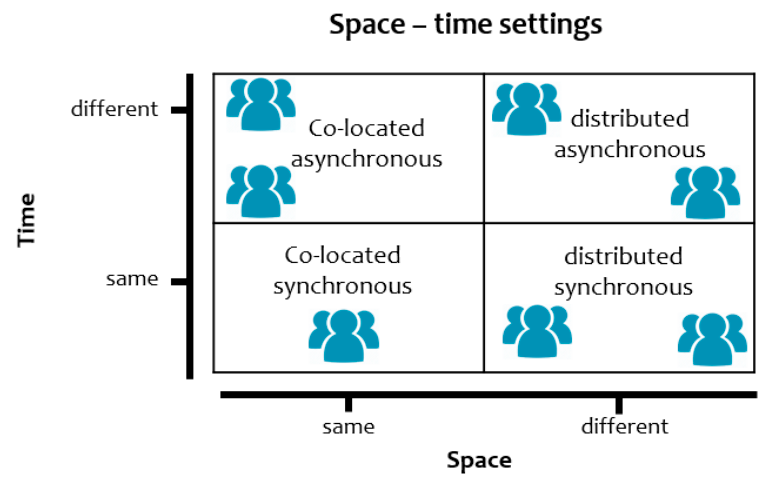
Figure 2. Space-time setting for group work collaboration. Based on [28].